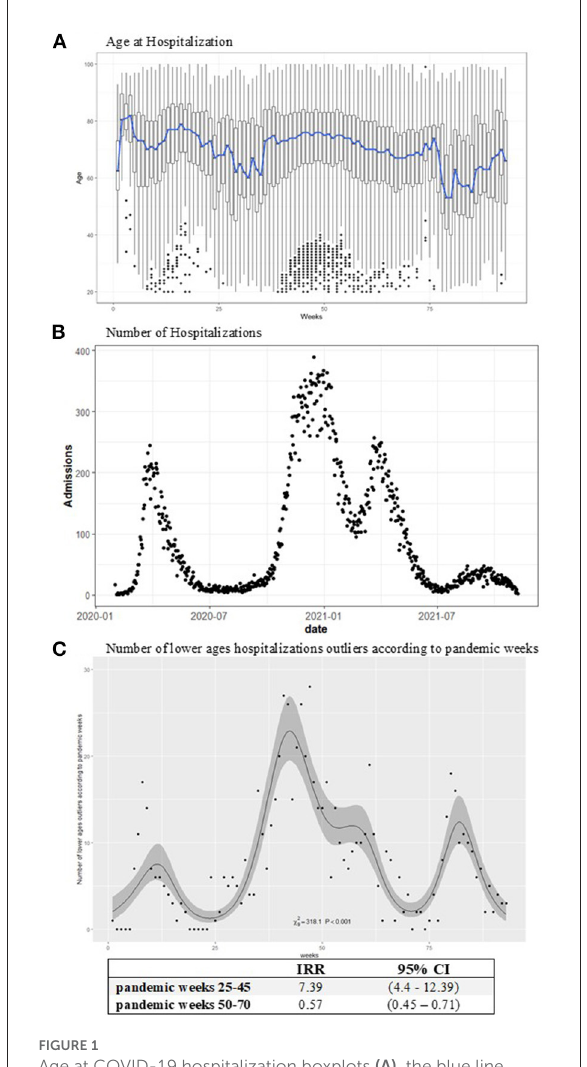
FIGURE1 Age at COVID-19 hospitalization boxplots (A) , the blue line represents the mean age by week. The number of hospitalizations according to days (B) . (C) Reports the observed (points) and estimated (line) number of lower ages outliers with the IRR effects according to pandemic weeks with 95% confidence intervals. The models have been estimated on the weekly data. An increasing incidence in the number of lower ages hospitalizations is observed in the expansive phase of the pandemic: 25–45 weeks IRR (95% CI) = 7.39 (4.4–12.39).